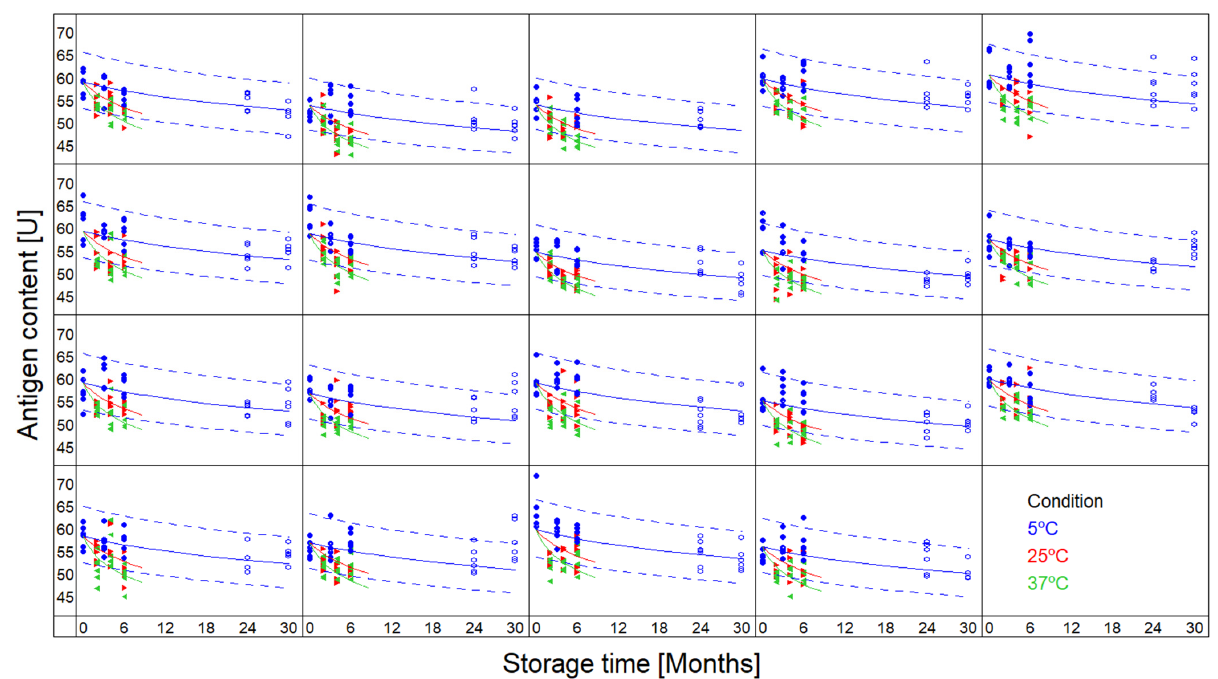
Figure 3. Antigenicity predictions based on vaccine 6 months’ data points (full circles) at +5 ◦ C (blue), +25 ◦ C (red), and +37 ◦ C (green) for 19 batches. Antigenicity predictions at +5 ◦ C are displayed as blue lines based on n th -order kinetics best fitting experimental data, including 95% two-sided prediction intervals (dashed-lines). Additional experimental data obtained later in time are displayed as open circles for verification.